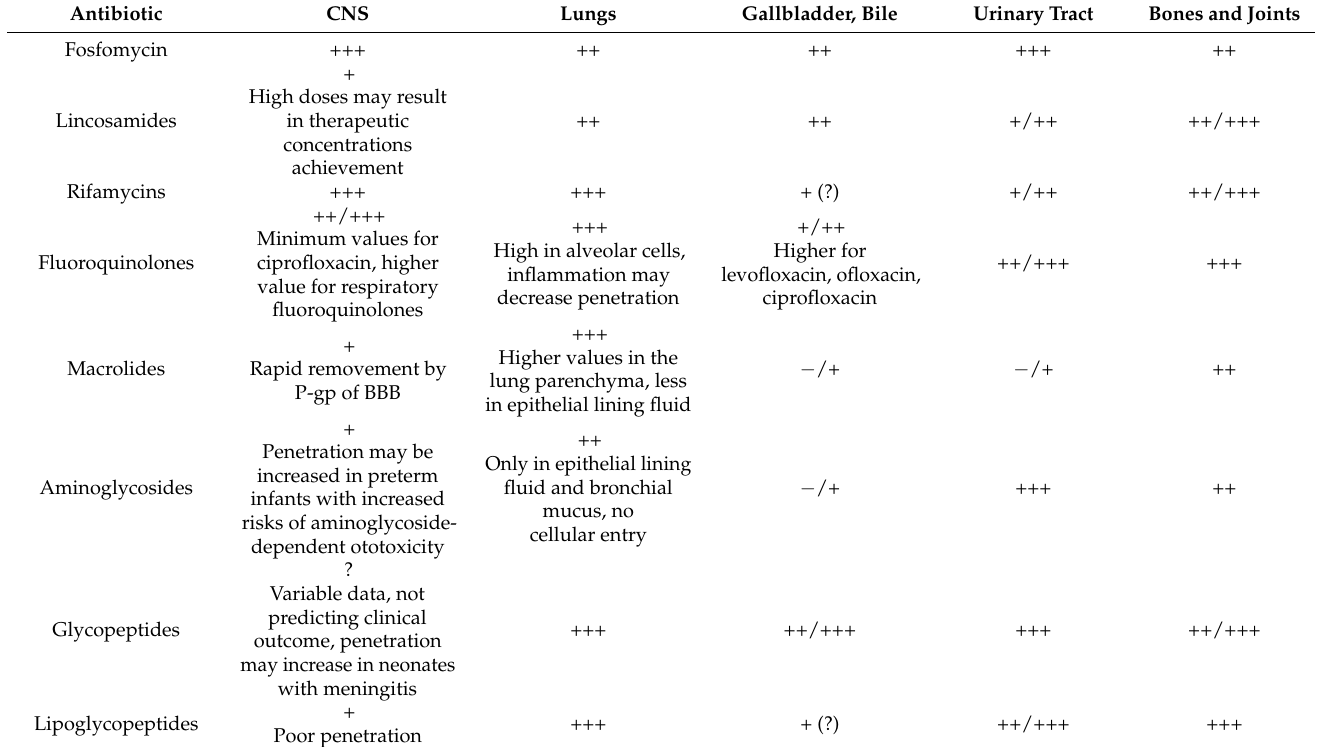
Table 5 includes data on the distribution of different groups of antibiotics. Table 5. Relative rates of antibiotics distribution to the different organs and